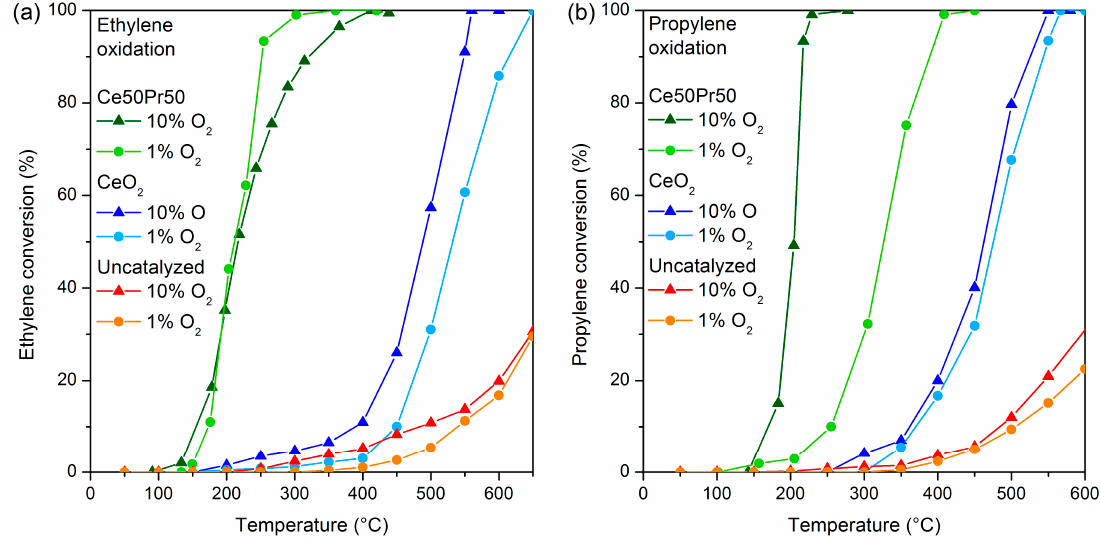
Figure 8. Ethylene ( a ) and propylene ( b ) conversion curves as a function of the temperature, obtained testing pure CeO 2 and the Ce50Pr50 catalyst in different oxygen conditions.